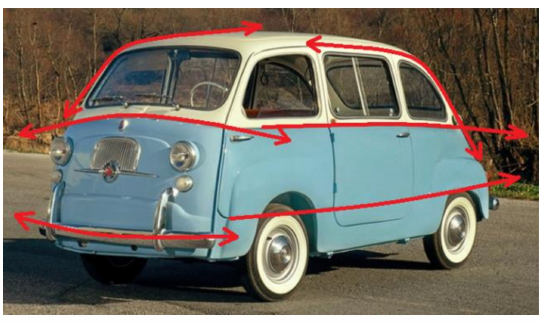
Figure 12. Sketch phase.